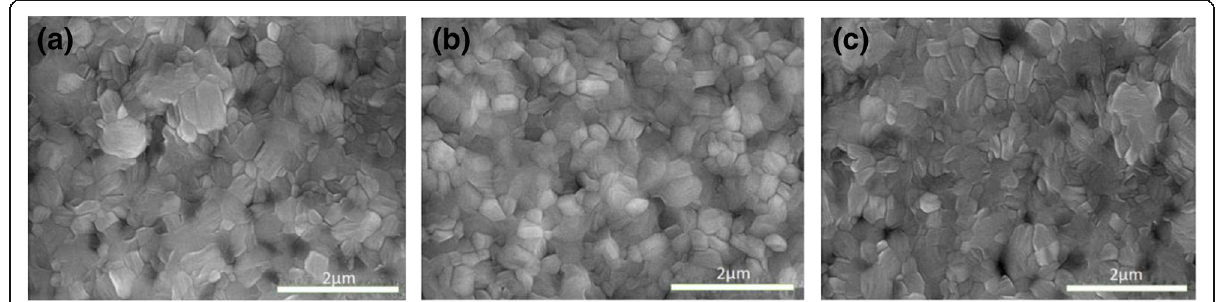
Fig. 1 The top-view SEM images of the CsPbI 2 Br-ZnCl 2 -Mncl 2 films. a CsPbI 2 Br-0%. b CsPbI 2 Br-0.25%. c CsPbI 2